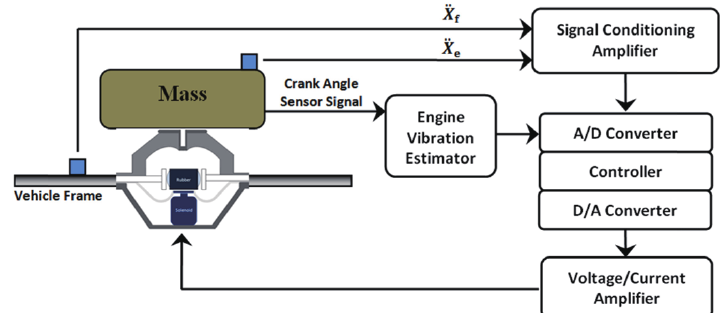
Fig. 13. Control system con fi guration.